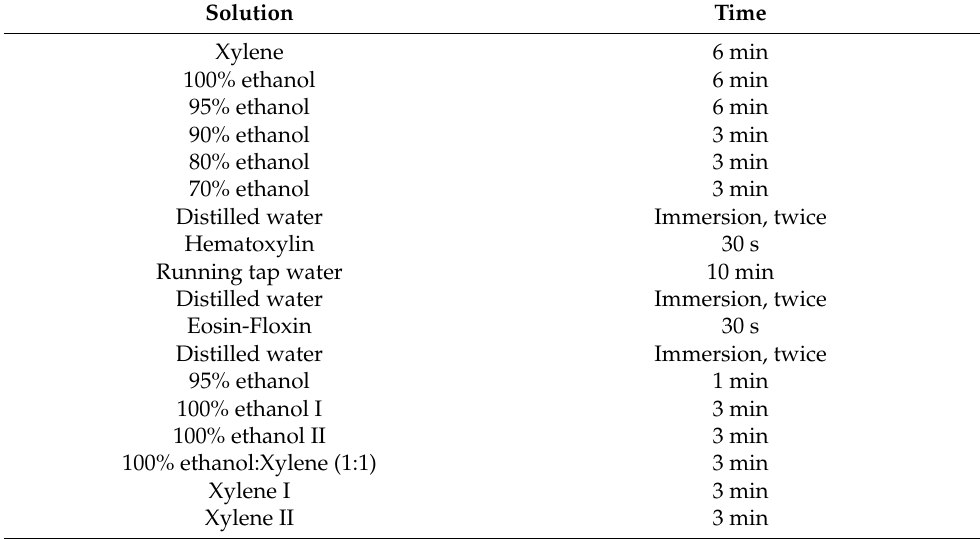
Table 2. H&E staining of sections in